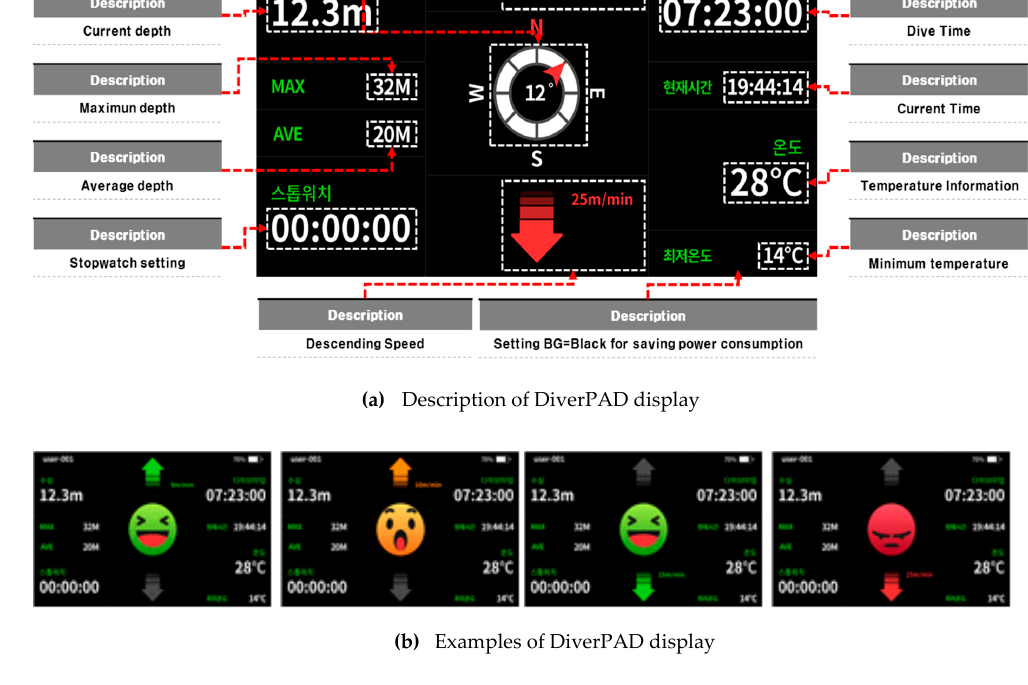
Figure 8. User interface of DiverPAD.